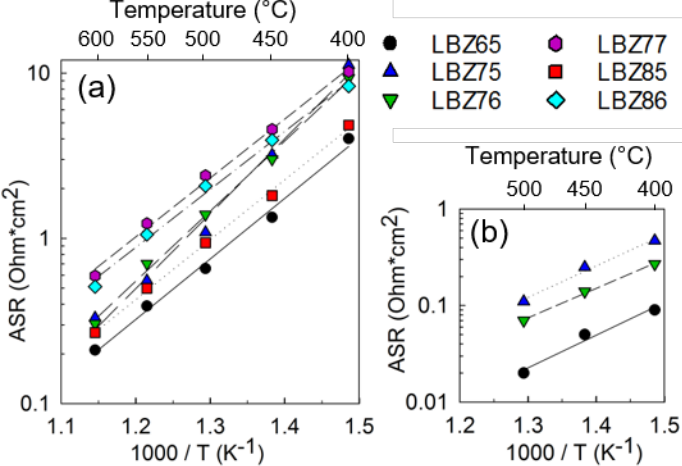
Figure 9. ( a ) Total area specific resistance (ASR) and ( b ) ASR of the (R 3 Q 3 ) charge transfer process of the LBZ composite cathodes in symmetric cell configuration in 3% moist synthetic air. Table 3. Cathode area specific resistance (ASR) in Ω·cm 2 from 400 to 600 °C at pH 2 O = 0.03 atm, total and per process activation energies and pre-exponential factor for the different LBZ cathodes.